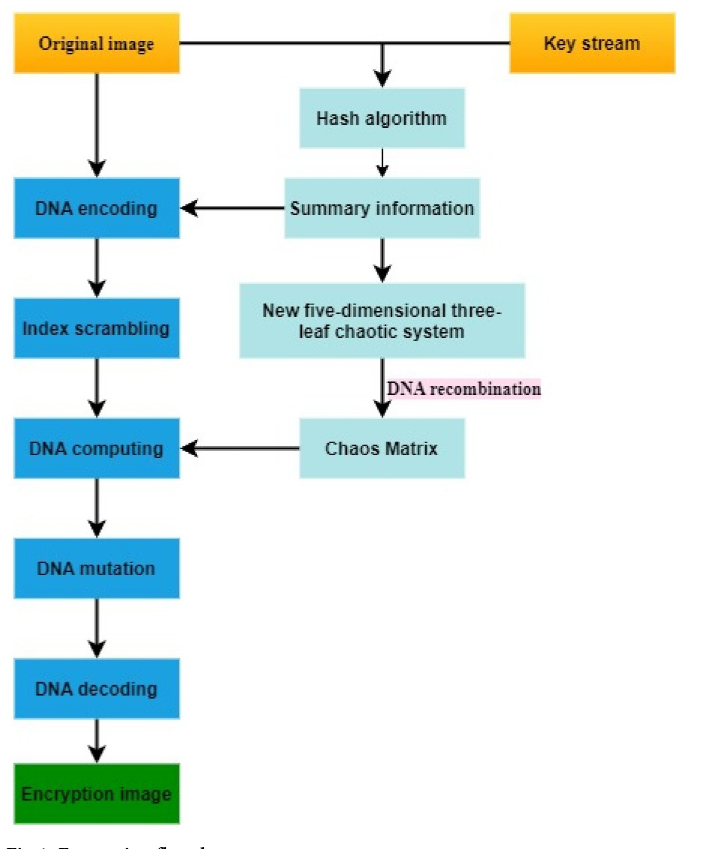
Fig 4. Encryption